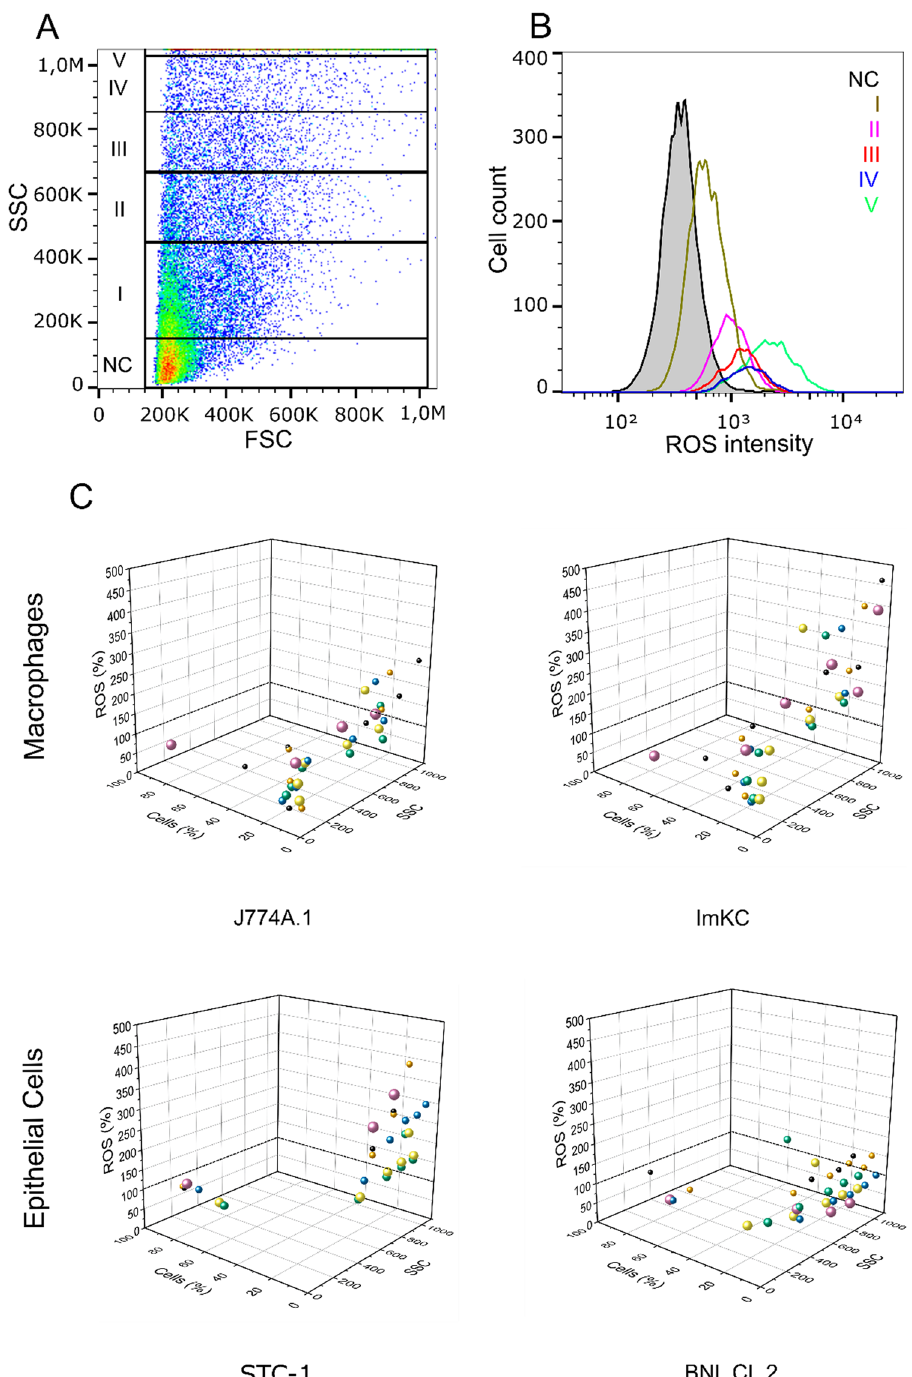
Figure 5. Correlation between ROS generation and intensity of cell-particle interaction. ( A ) Representative gating strategy for rising PCI. Gate NC represents cells with no particle interactions, I–V show increasing PCI (SSC = side scatter, FSC = forward scatter). ( B ) The respective ROS intensity for gated cells shown in ( A ). ( C ) Correlation between PCI, normalized ROS-quantity, and gated cell count. ROS quantity was normalized (control: cells incubated without particles). MFI is the mean SSC value of respectively gated cells. The dashed line highlights the relevant 100% ROS line, the back-ground ROS production determined in non-treated cells cultivated at otherwise similar conditions. Used particle concentration: h c Table 2 (black circle = 0.2 µm, orange circle = 0.5 µm, blue circle = 1 µm, green circle = 2 µm, yellow circle = 3 µm, purple circle = 6